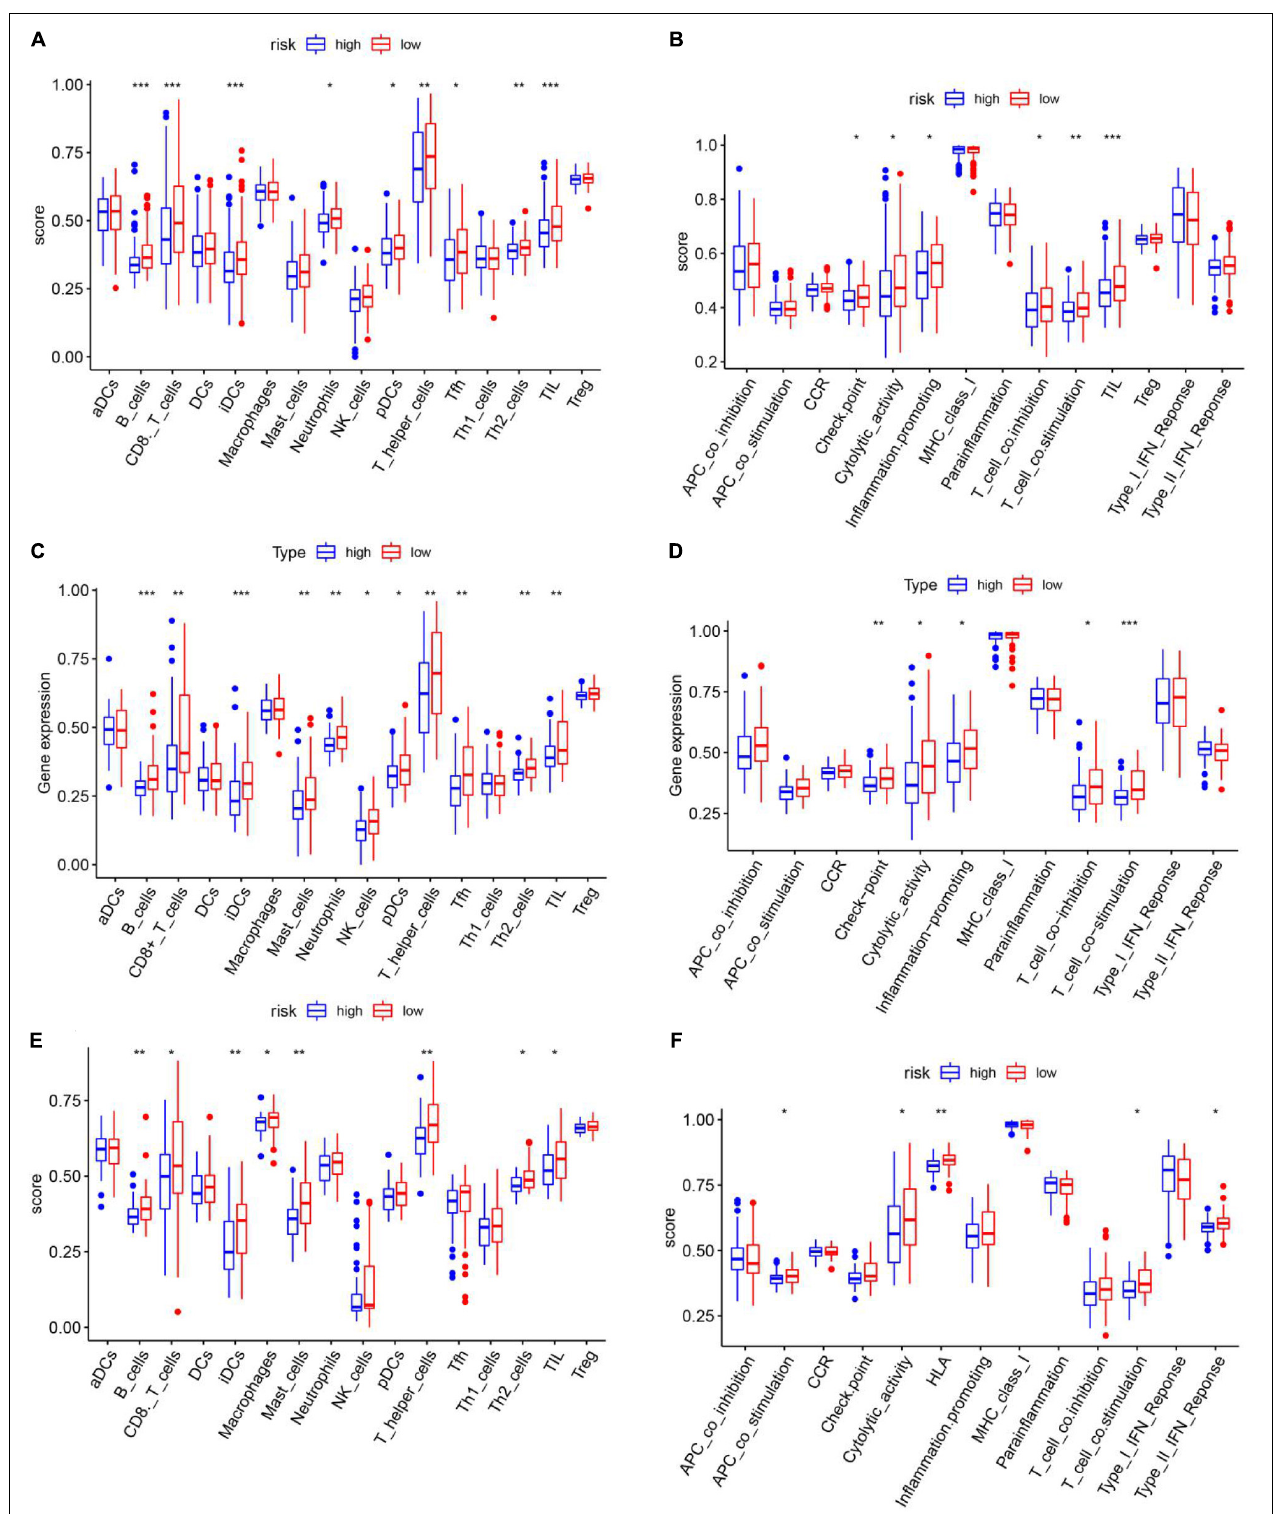
FIGURE 9 | Single-sample gene set enrichment analysis of the immune cell infiltration status of different risk groups in the cancer genome atlas training set. (A,B) TCGA validation set (C,D) and GEO validation set (E,F) . (A,C,E) Immune cell infiltration status in high- and low-risk groups. (B,D,F) Immune functional enrichment in the different risk